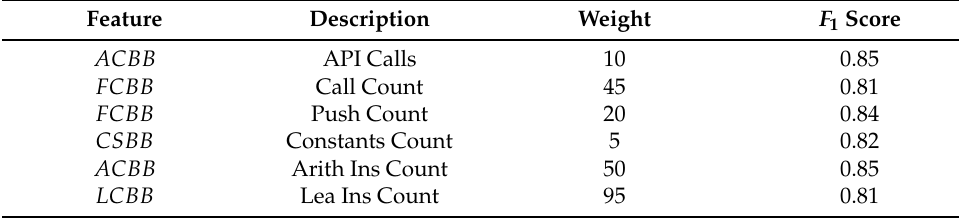
Table 13. Bipartite Matching Weight Selection.